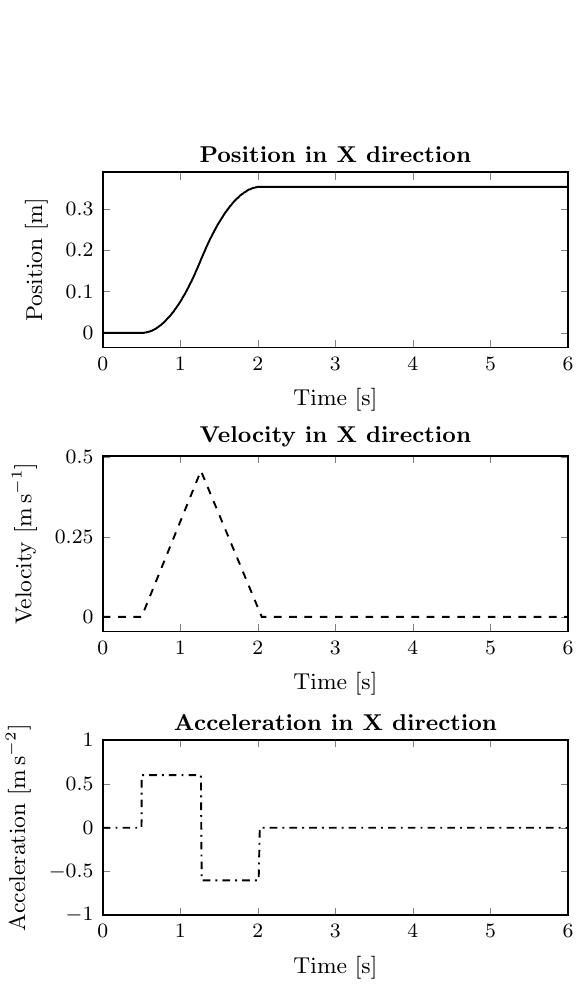
Figure 7: Reference trajectory for the first experiment. Position, velocity, and acceleration profiles along the Cartesian x